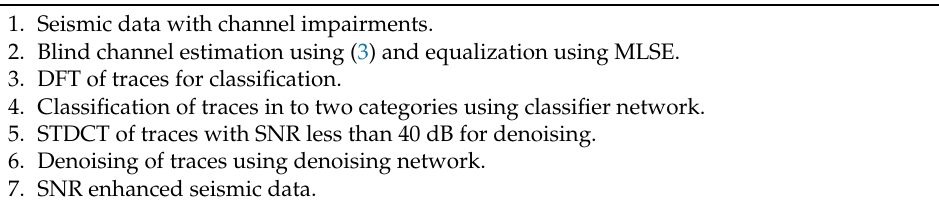
Table 1. Summary of the proposed